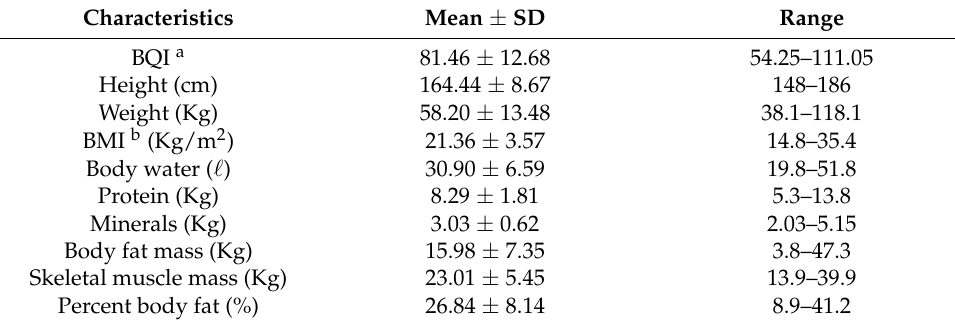
Table 2. Distribution of body compositions ( n =